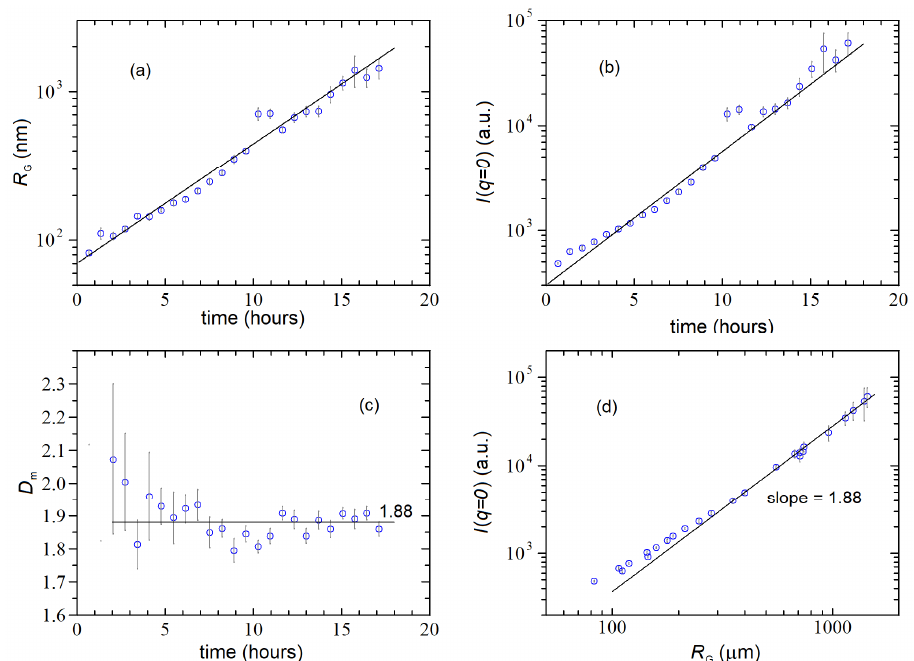
Figure 7. Time behavior of the gyration radius R G ( a ), mass M ( b ) and fractal dimension D m ( c ) for the same aggregation clusters of Figure 6a; ( d ) behavior of zero- q intensity I ( q = 0 ) as a function of the cluster gyration radius R G . The three slopes reported in panels ( a , b , d ) are consistent with an RLCA growth modality characterized by a mass fractal dimension D m =